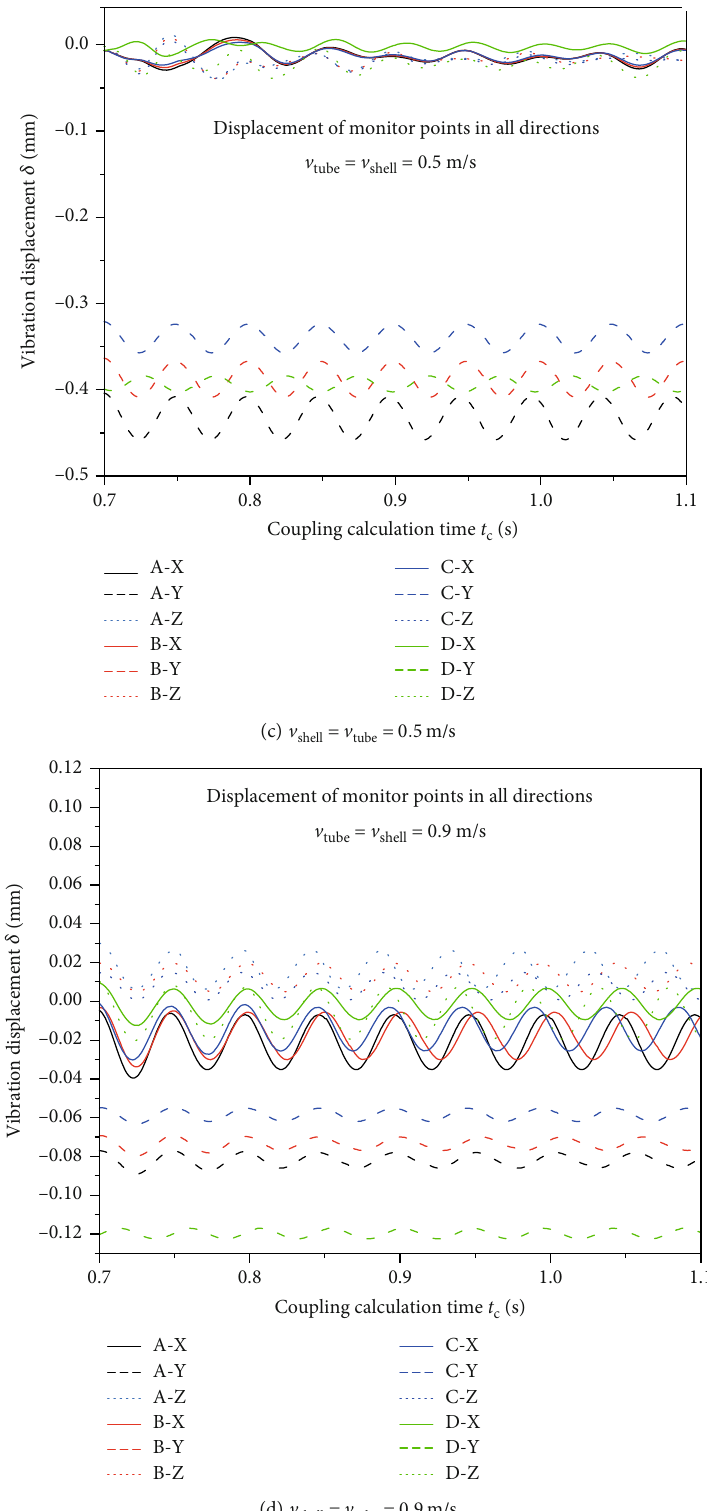
Figure 6: The vibration displacement under di ff erent inlet